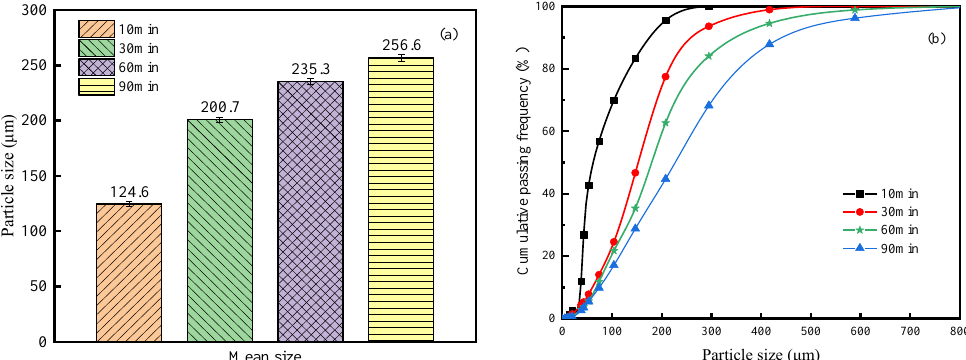
Figure 6. Effect of carbothermic reduction time on size characteristics of ferronickel particles: ( a ) mean size; ( b ) cumulative passing frequency distribution.